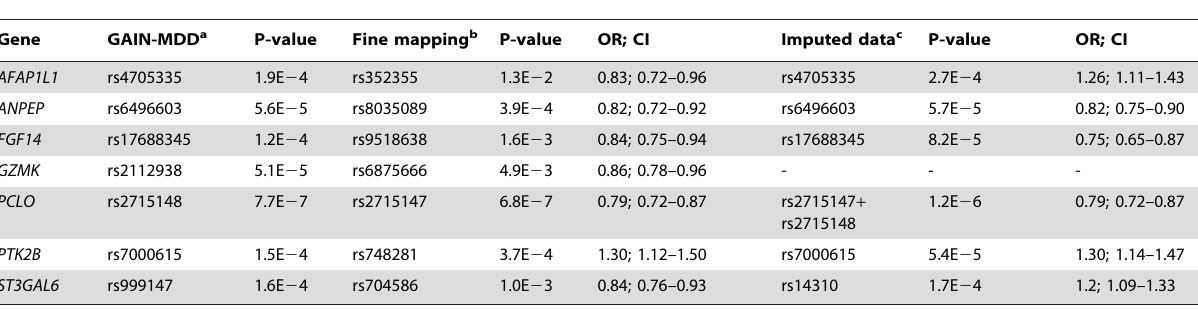
Table 3. rs-numbers and P-values for the SNPs with the lowest P-values.